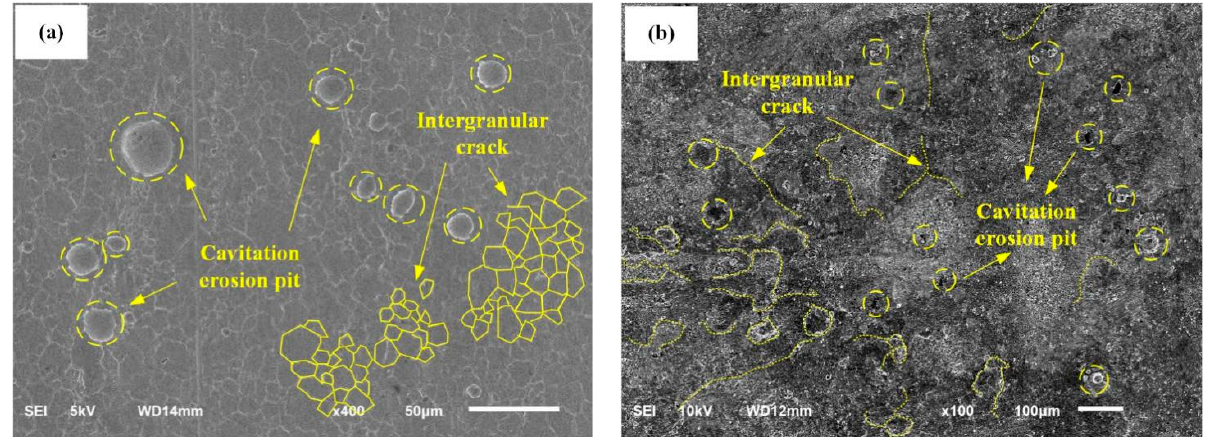
Figure 12. SEM images of sample surface impacted by jet with the pressure of 200 MPa: ( a ) impact time of 40 s; ( b ) impact time of 50 s.